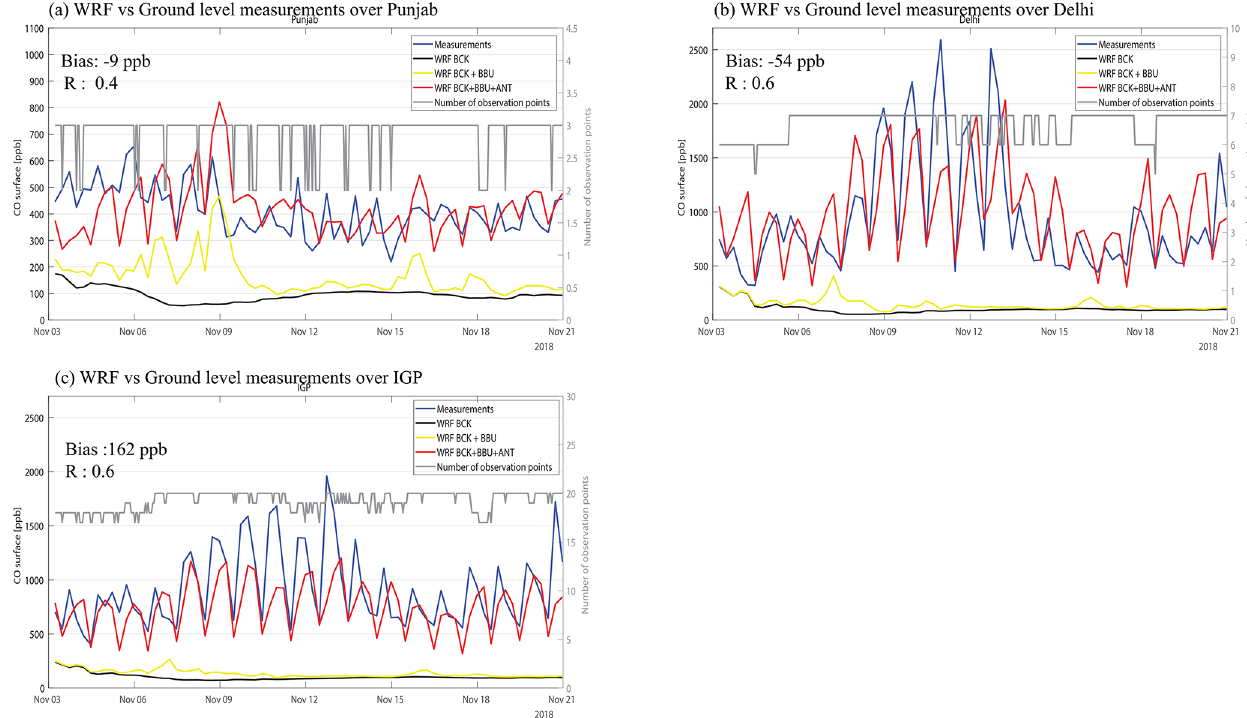
Figure 7. Ground-level CO measurements and WRF model simulations for the period 3–20 November 2018 over (a) the IGP region, (b) Delhi, and (c) Punjab. Note that different y -axis scale ranges are used in the panels for a better visualization of the signals.